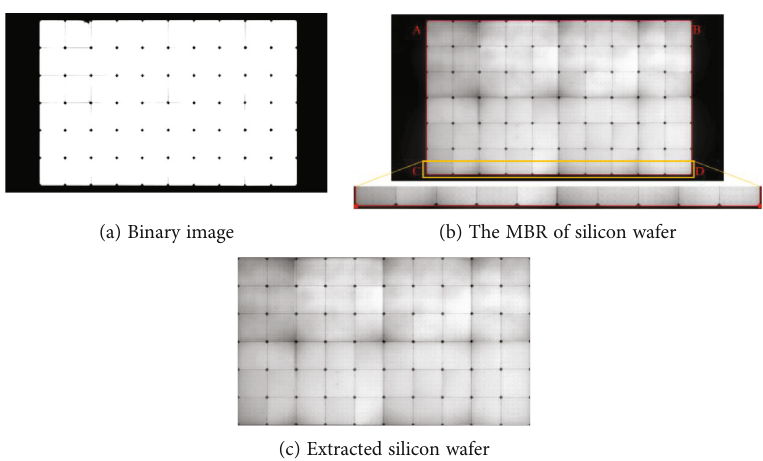
Figure 3: The process of component region extraction with Table 1: Description of the corner coordinates of the MBR. Corner point